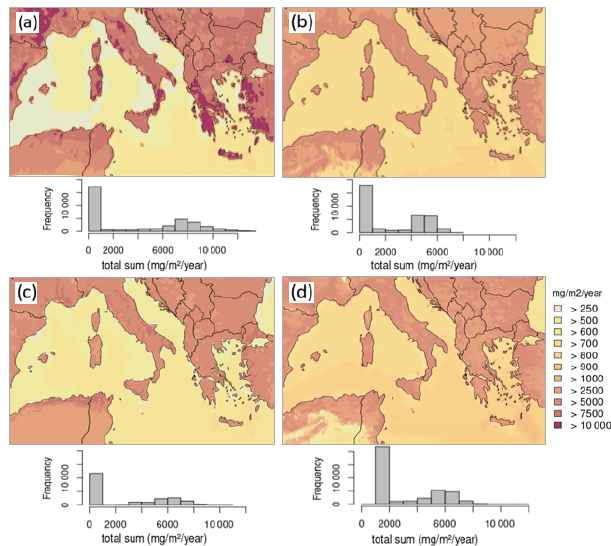
Figure 14. Annual total dry deposition of O 3 . (a) CAMx; (b) CHIMERE; (c) CMAQ; (d) LOTOS-EUROS. Below the do- main figure the respective frequency distribution is displayed for the annual mean O 3 dry deposition, referring to the whole model domain.